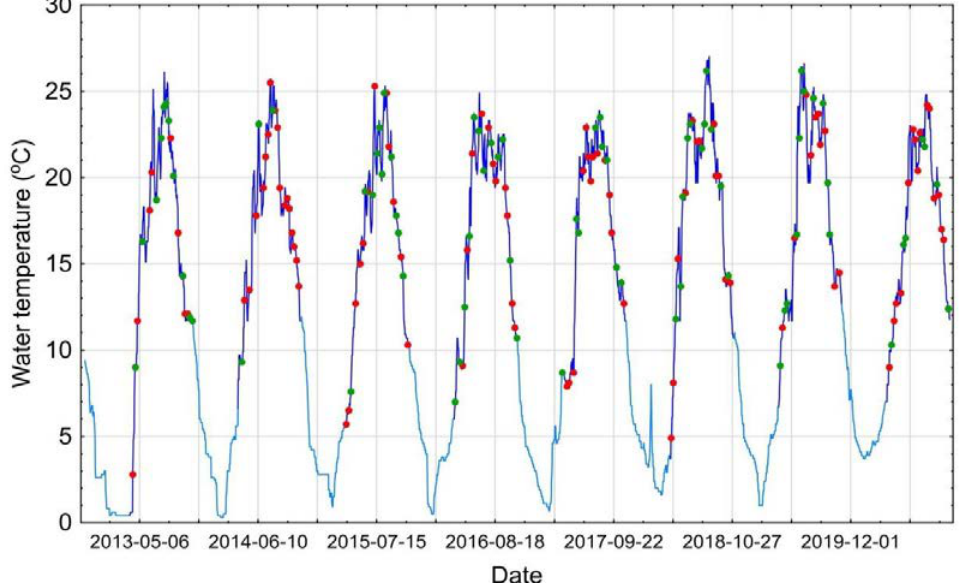
Figure 4. Data availability of Landsat 8 Collection 2 Level 1 in the background of the daily water temperatures of the Niesłysz Lake—the dark blue line presents the water temperatures in the period from April to October, the light blue line presents the water temperatures in the period from November to March, green and red dots present the dates of the imageries applied and excluded from the analysis,